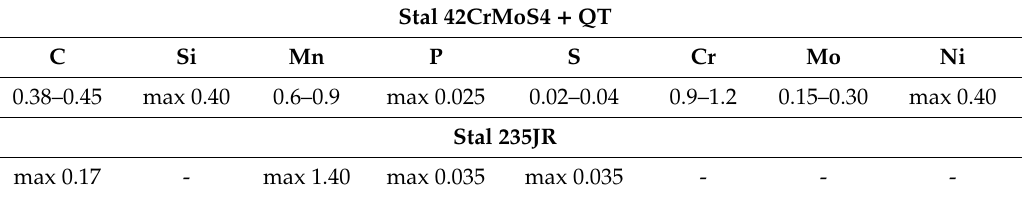
Table 6. Comparison of the qualitative composition of 42CrMoS4 + QT and S235JR steels [23,24]. Stal 42CrMoS4 + QT